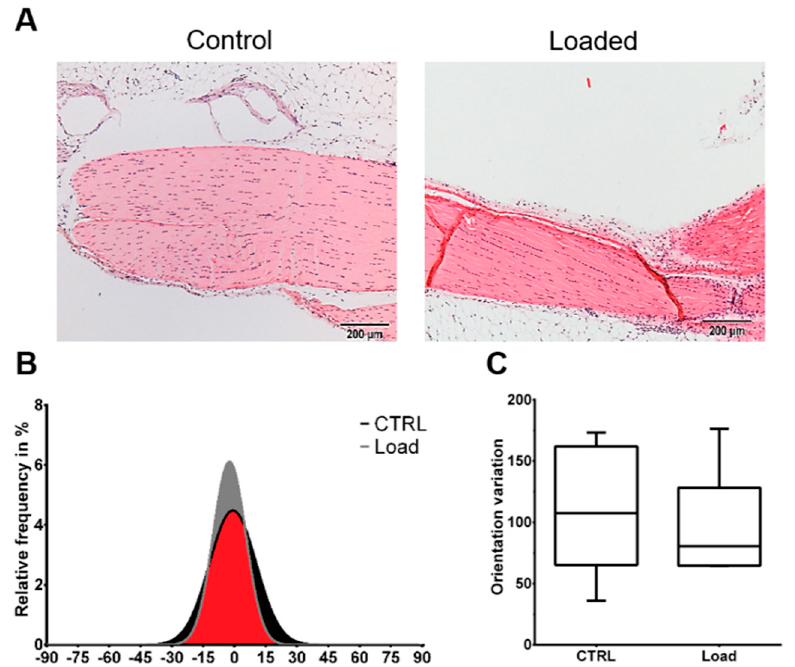
Figure 1. Mechanical loading did not induce histological alterations in the in vivo loaded Achilles tendon. The loaded and non-loaded Achilles tendons were dissected and further processed for histological analysis. ( A ) Representative Hematoxylin and Eosin images of the loaded and non-loaded Achilles tendon. Scale bar: 200 µ m. ( B ) Collagen fiber distribution. ( C ) Variation of fiber orientation ( n = 6).